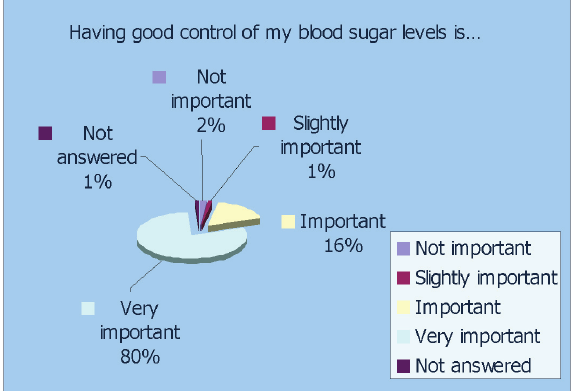
Figure 1. Diabetic patients’ perceived importance of blood sugar control.